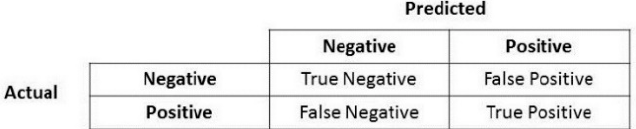
Figure 9. Confusion matrix.